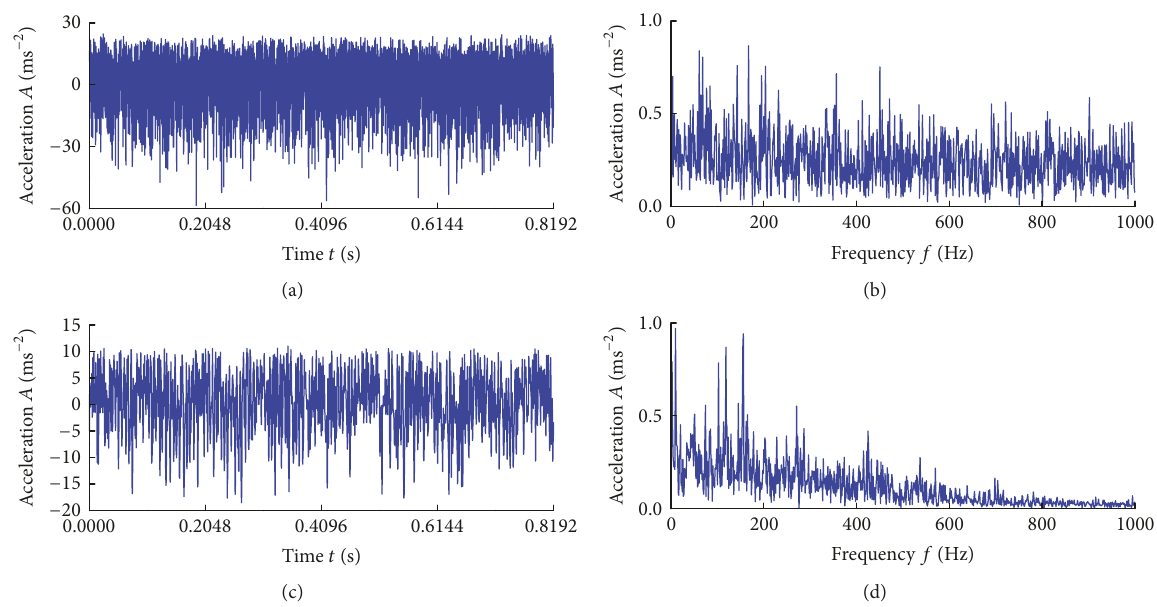
Figure 15: The intrinsic envelopes extracted by the manifold with Isomap and their envelope spectra: (a) IMFs-envelope space of EEMD, (b) the envelope spectra of (a), (c) multiscale envelope space of WPT, and (d) the envelope spectra of (c).